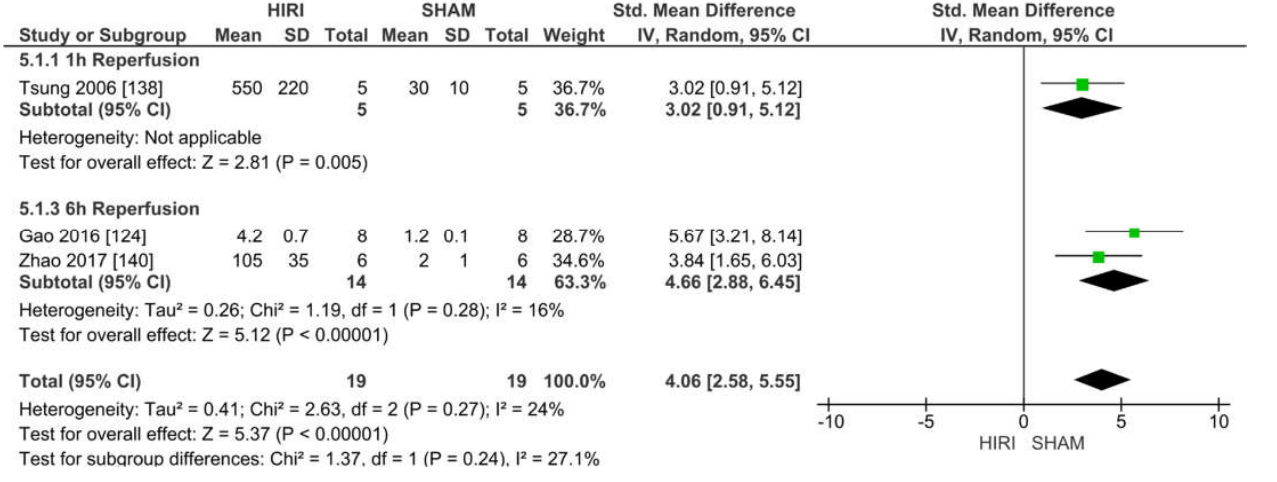
Figure 11. Forest plot of 70% HIRI in mice and 60 min warm ischaemia time grouped by reperfusion time between 1 and 6 h. time between 1 and 6